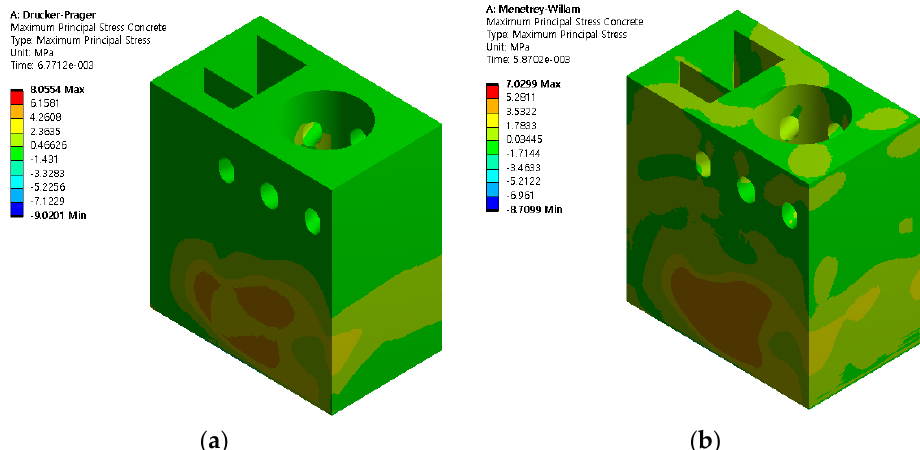
Figure 7. Principal stress history in cavity wall concrete with time. ( a ) The Drucker-Prager model. ( b ) The Menetrey-William model.